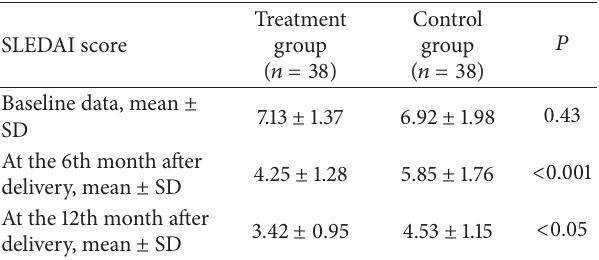
Table 3: Change of SLEDAI within 1 years after delivery (mean ± SD).